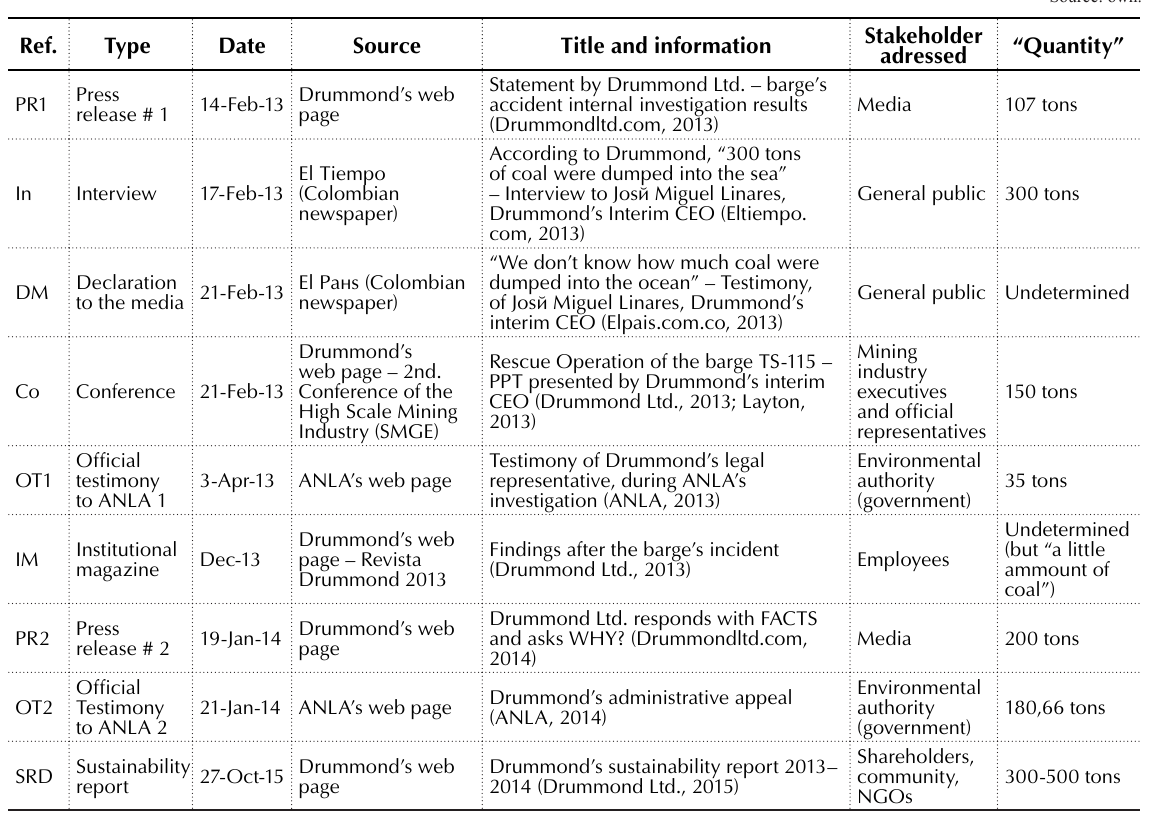
Table 2. Mentions of the amount of coal dumped into the